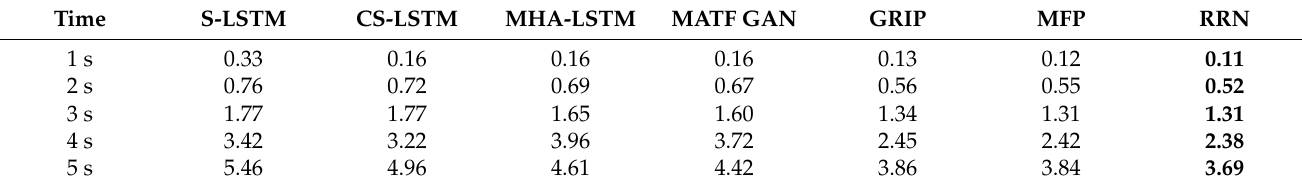
Table 2. RMSE (in meters) results of experiments on the INTERACTION. We compare the perfor- mance of several baseline models with the RRN over the 5-s prediction horizon.